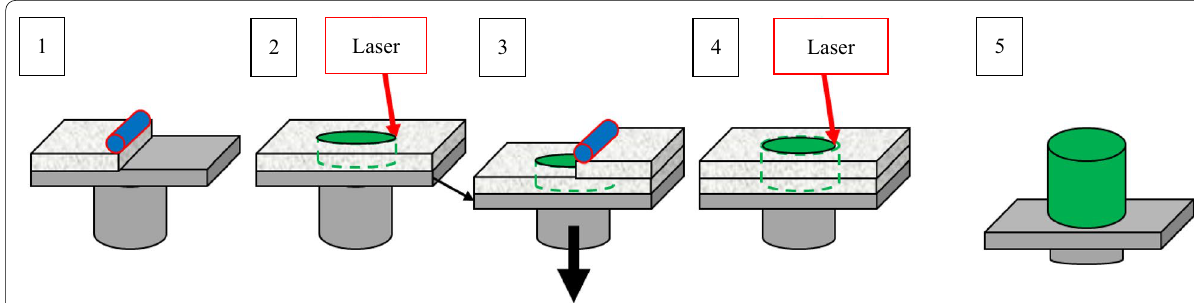
Figure 1 L-PBF process schematic